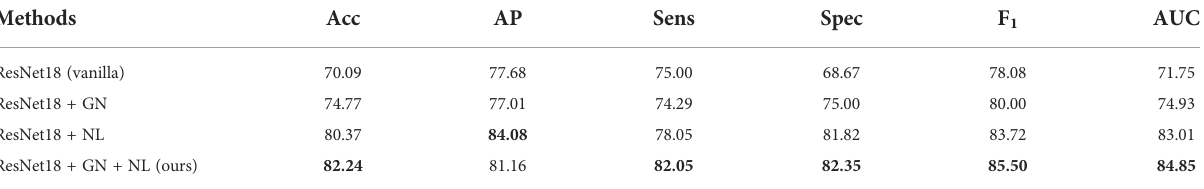
TABLE 1 Quantitative comparisons for the effectiveness of deformed extraction modules.